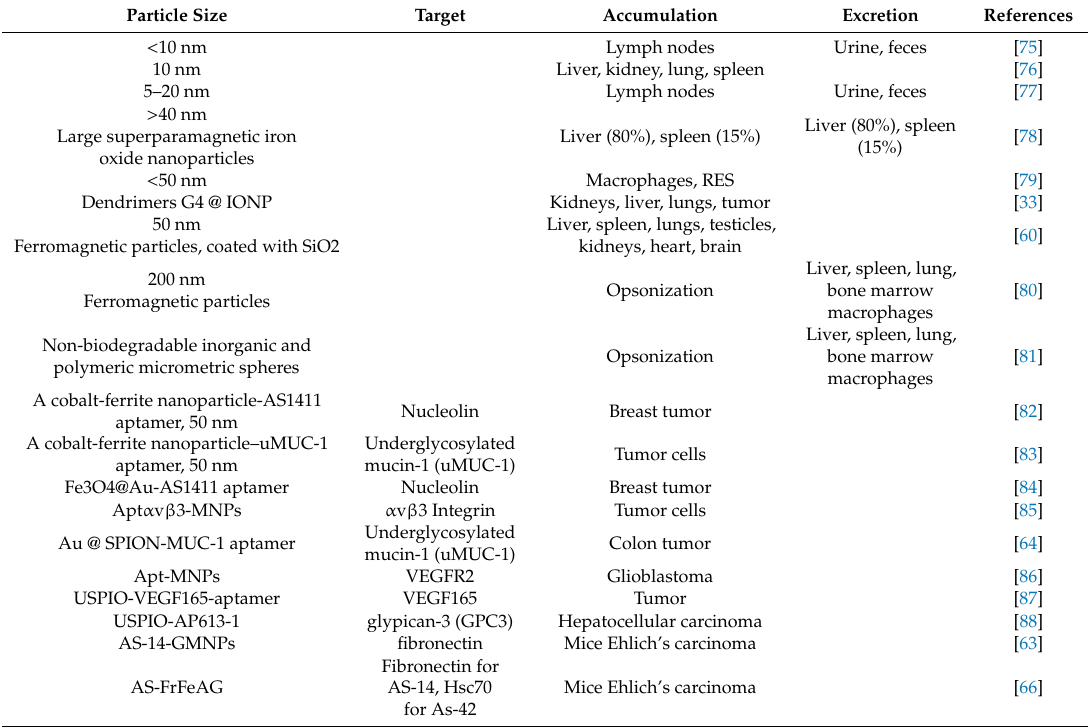
Table 1. The distribution of MNPs in organs and tissues, depending on their